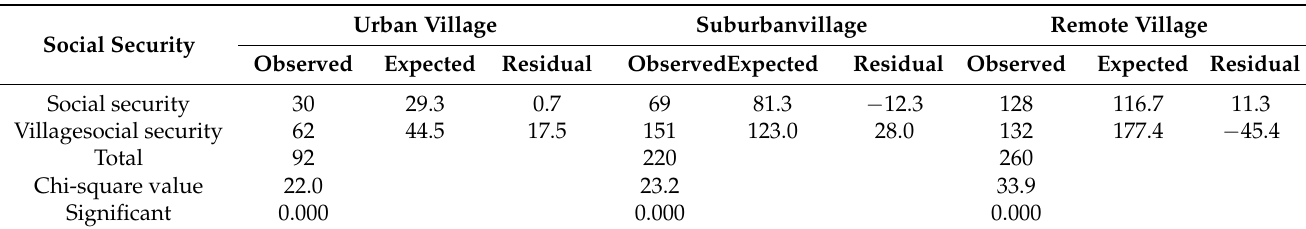
Table 3. Non-parametric chi-square test of social security coverage in rural villages.